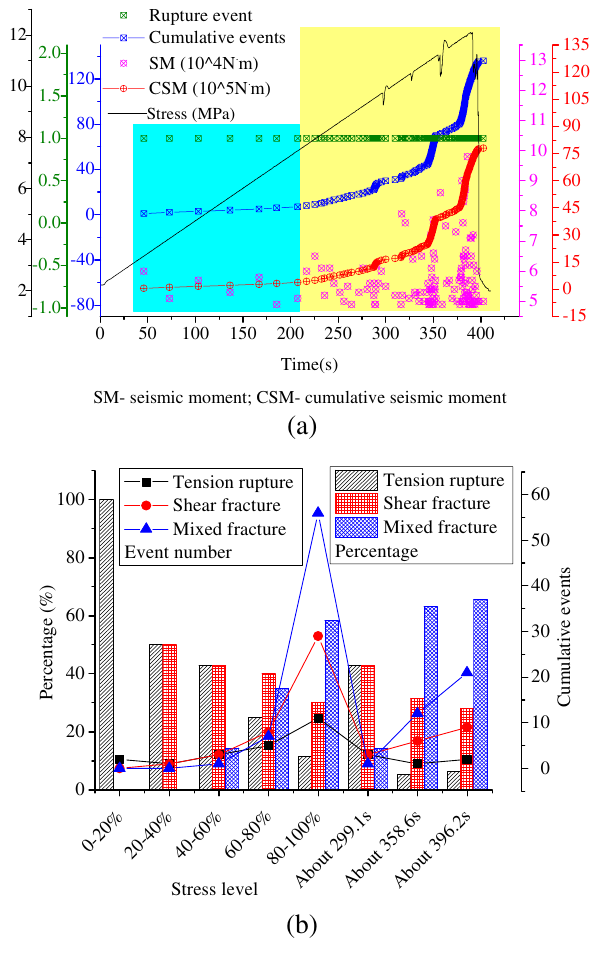
Figure 14. Statistical results of fracture events revealed by AE moment tensor inversion duirng the loading process of gas-bearing coal. ( a ) Temporal variation of fracture events with loading time. ( b ) Proportion of different types of fracture